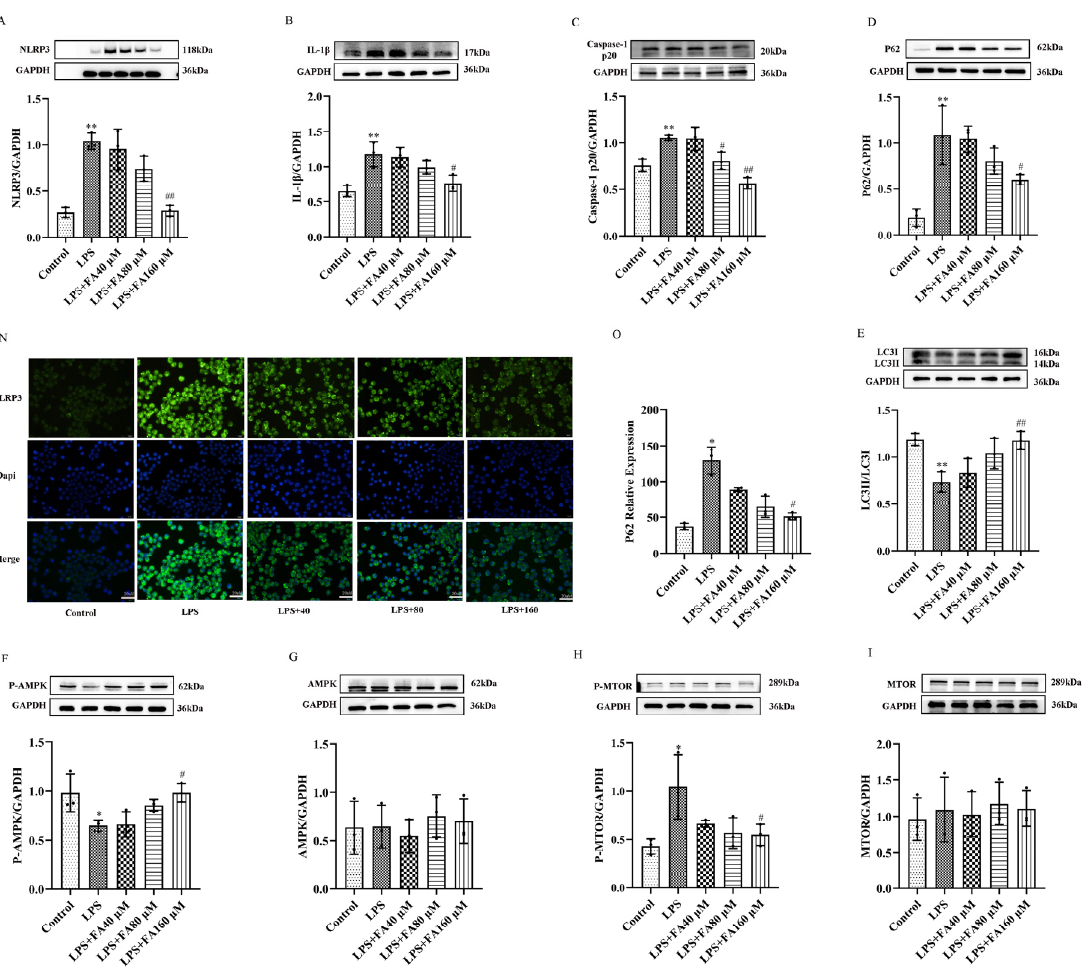
Figure 4. FA inhibits pro-inflammatory mediators and associated key targets in LPs-induced BV2 mi- croglia. ( A – C ) NLRP3, IL-1 β and caspase-1 p20 were detected by Western blot. FA restored the autophagy of BV2 microglia inhibited by LPS. ( D , E ) Autophagy-related proteins P62 and LC3 were detected by Western blot. ( F – I ) Western blot analysis showed the expression of P-AMPK/GAPDH, AMPK/GAPDH, P-mTOR/GAPDH and mTOR/GAPDH proteins. ( N , O ) The expression of NLRP3 (50 × magnification) in BV2 microglia was observed via inverted fluorescence microscope. The nuclei were stained with Hoechst 33,342 (blue). Scale bar = 20 µ M. Data are means ± standard deviations (SDs) ( n = 3). ** p < 0.01, * p < 0.05, vs. control; ## p < 0.01, # p < 0.05, vs. LPS.